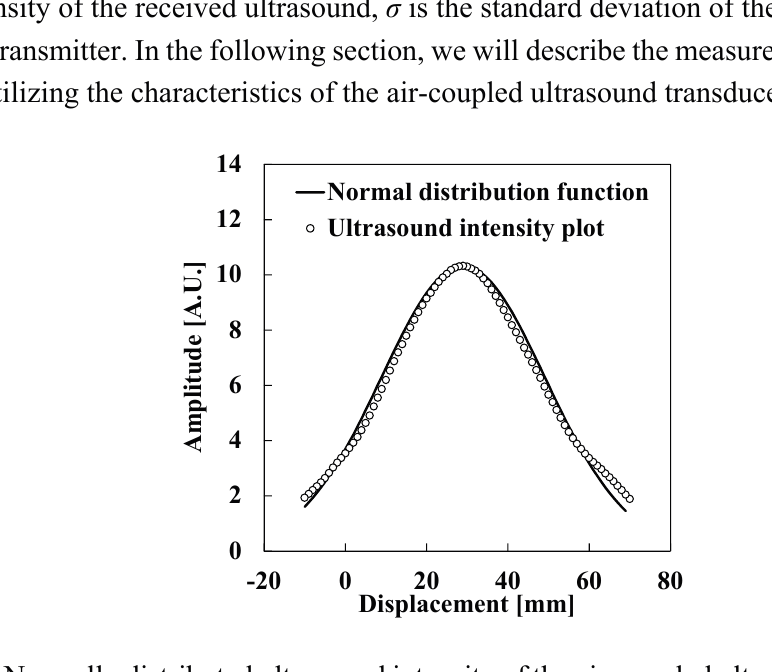
Figure 5. Normally distributed ultrasound intensity of the air-coupled ultrasound